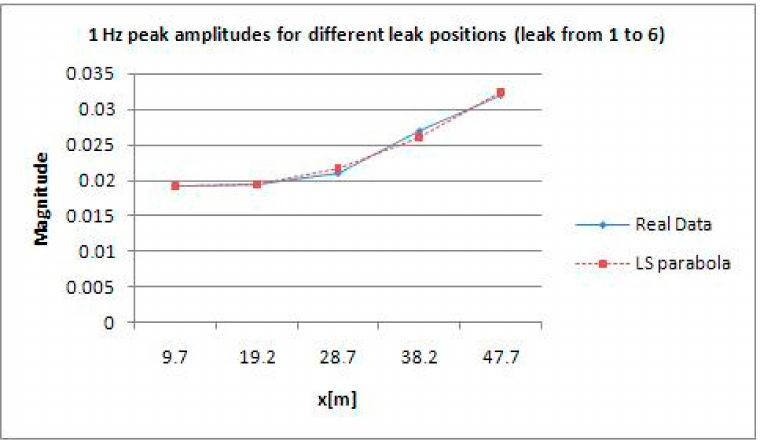
Figure 14. Example of quadratic regression implementation for retrieving leak position (leak from 1 to